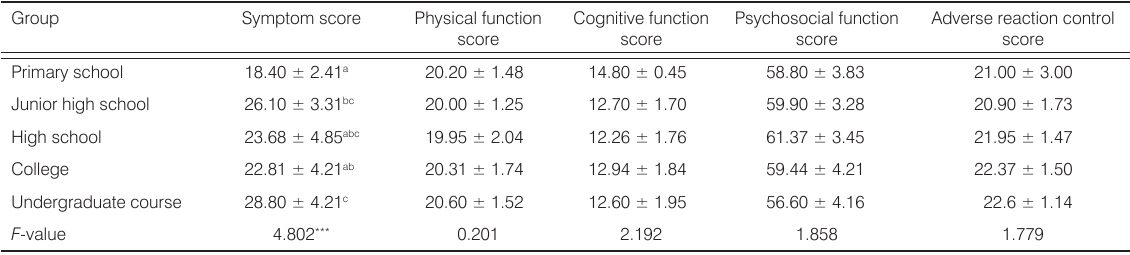
Table 4. Comparison of quality-of-life scores of patients with different educational backgrounds in the experimental group after 3 wk ( ± ) x s